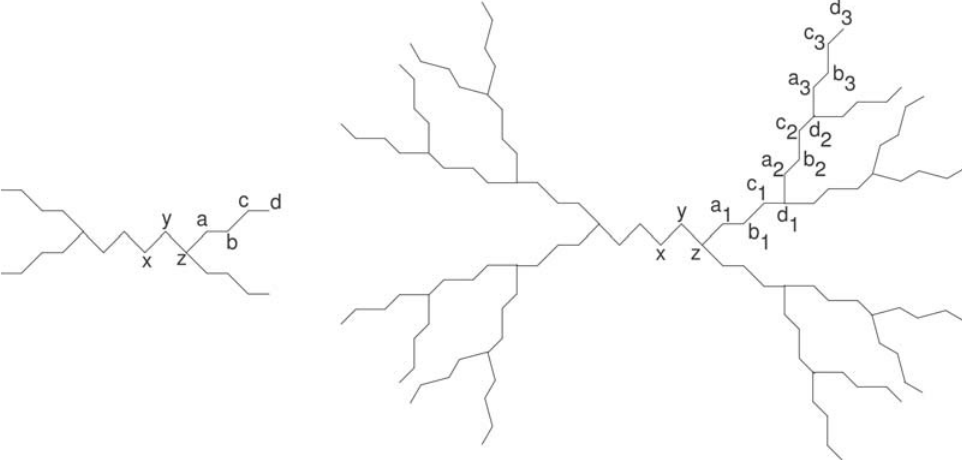
Figure 2: PD [r] with r = 1 and r = 3. Table 1 : The characterizations of elements of V ( SD [r]). Representatives